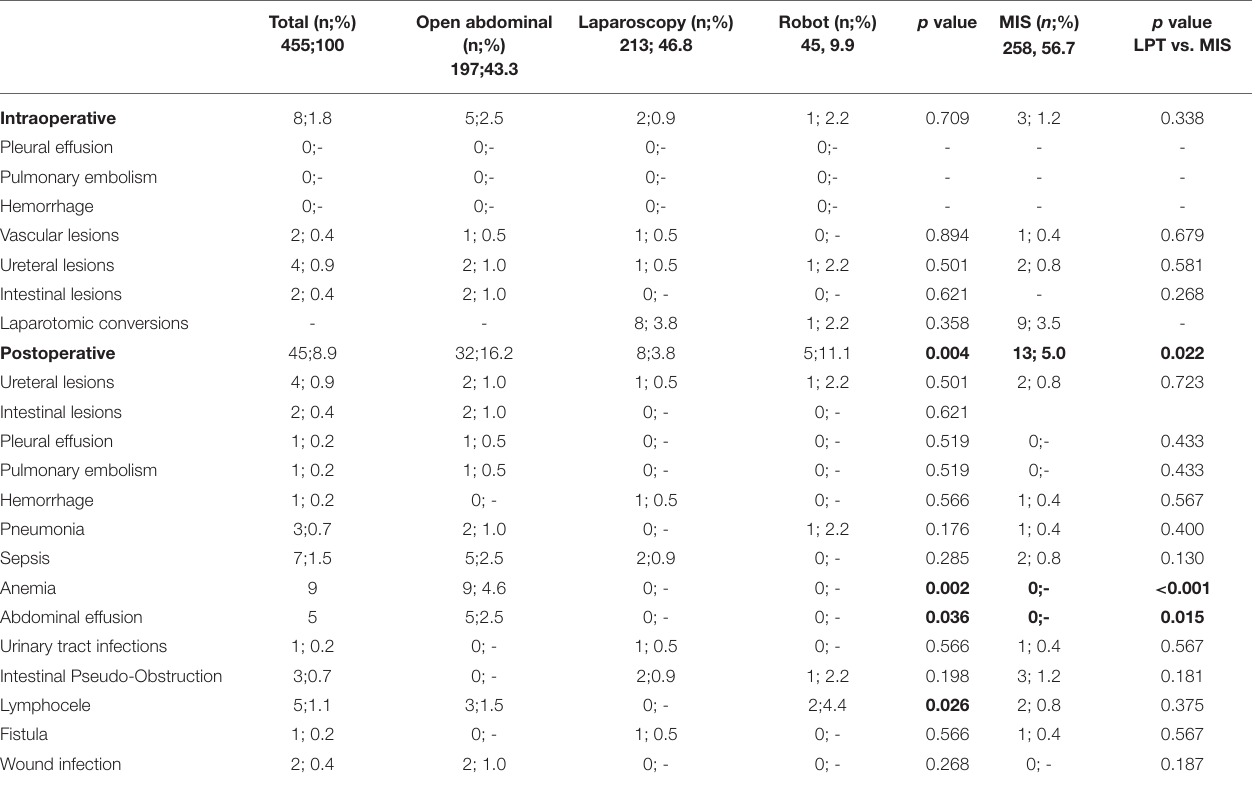
TABLE 2 | Intraoperative and postoperative complications.